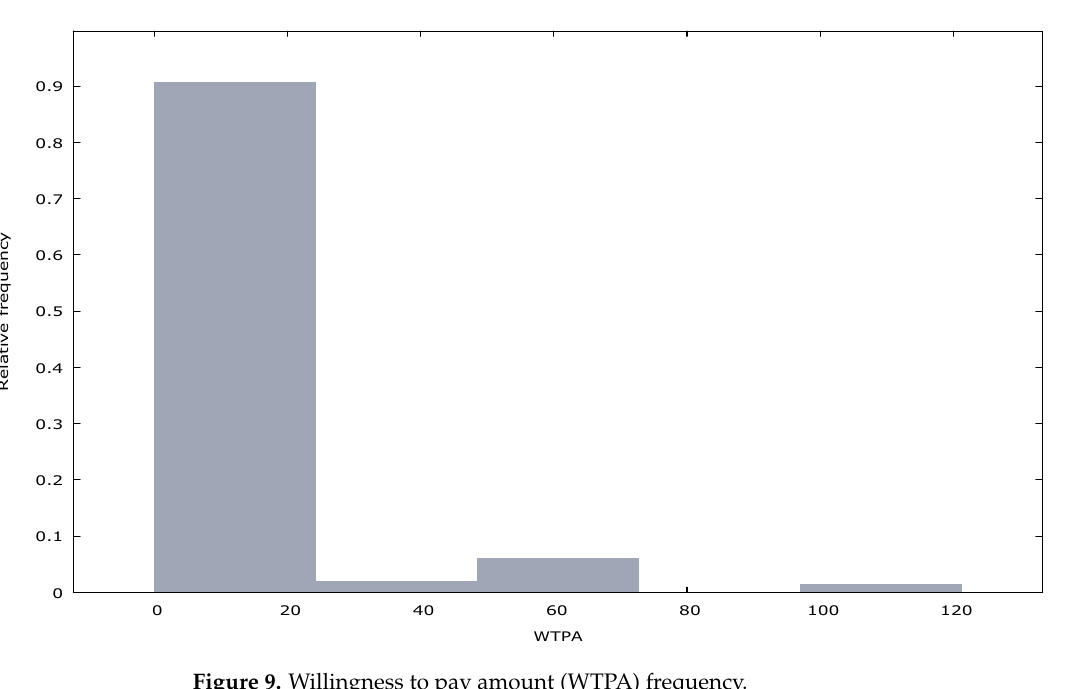
Figure 8. Willingness to pay amount (WTPA).